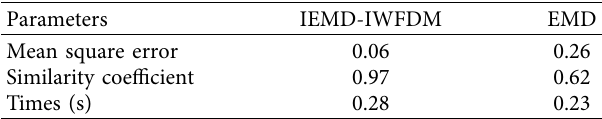
Table 1: Evaluation of denoising performance for real building vibration